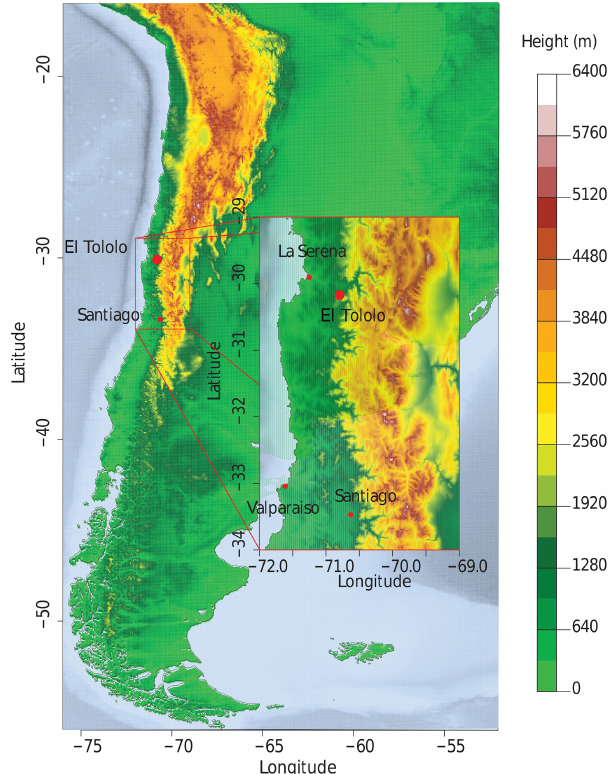
Figure 1. Position of El Tololo, La Serena, Valparaíso, and Santiago de Chile including topographic information. Terrain data source: NOAA ETOPO1, plotted using marmap (Pante and Simon-Bouhet,